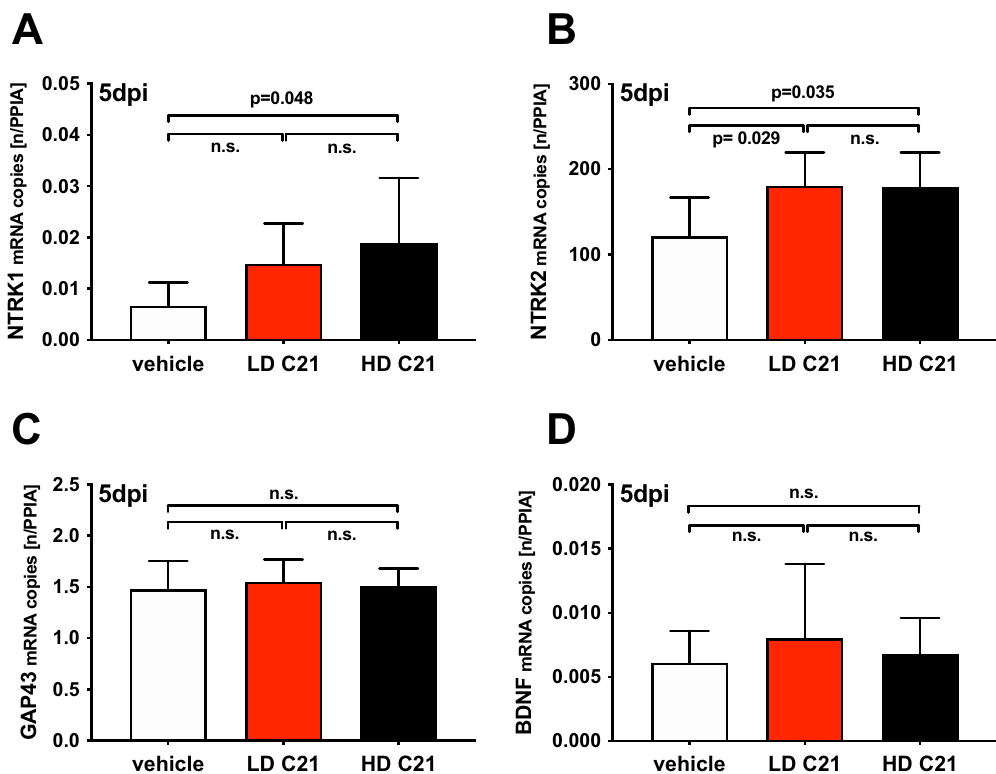
Figure 2. Effect of AT2 activation with C21 on neurotrophin receptor and effector expression: Vehicle-treated WT mice ( n = 9; white) were compared to WT mice treated with low (0.03 mg/kg; LD C21; n = 9; red), or high dose (0.1 mg/kg; HD C21; n = 9; black) of C21 at 5 days post-injury (5dpi); the data are expressed as mean ± SD; n.s. = not significant. ( A ) , (B ) There were dose-dependent elevated gene expressions of the neurotrophin receptors NTRK1 in HD C21 and of NTRK2 in LD and HD C21 compared to those in the vehicle-treated mice ( p < 0.05). ( C ) , ( D ) The gene expressions of the neurotrophins GAP43 and BDNF were not regulated differently between the vehicle- and C21-treated